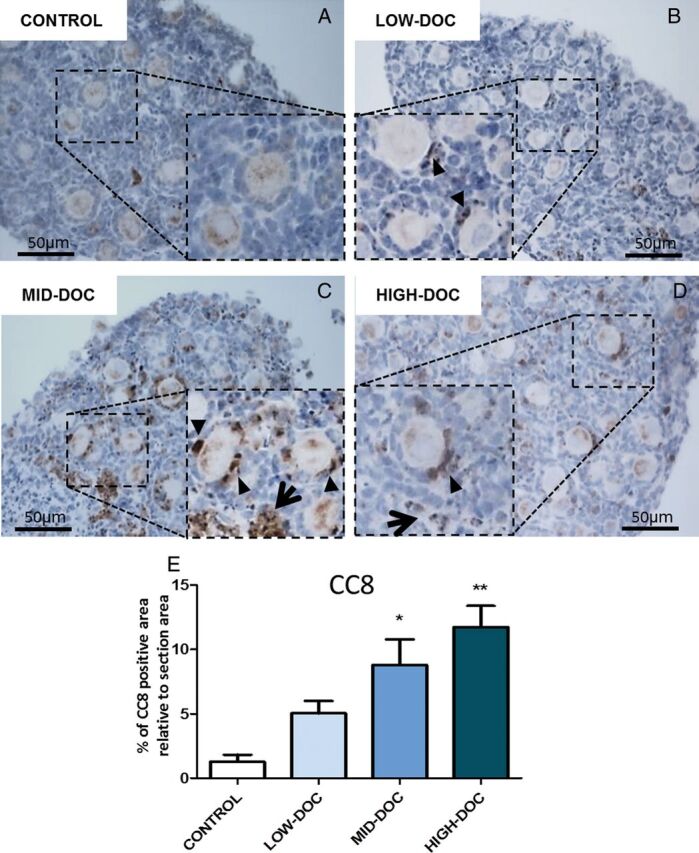
Docetaxel activates caspase 8. (A–D) Representative photomicrographs of mouse ovarian sections processed using immunohistochemistry to localize cleaved caspase 8 (CC8: brown), to illustrate the degree of apoptosis. (A) CONTROL ovary exhibiting little sign of CC8-positive apoptotic cells. (B–D) DOC-treated sections displaying marked apoptosis staining, with CC8 signal evident in many GCs (arrowhead) and stromal cells (arrow). Sections were counterstained with Haematoxylin (blue). Insets represent magnified images of respective framed areas. (E) Semi-automated analysis of immunohistochemistry. Exposure to DOC increased expression of CC8 relative to section area with the MID- and HIGH-DOC doses. Total of ovaries used in three independent experiments: CONTROL = 4, LOW-DOC = 4, MID-DOC = 6 and HIGH-DOC = 6. Kruskal–Wallis followed by Dunn post hoc tests were applied. Data are mean ± SEM. P < 0.05 (*), P < 0.01 (**) for DOC versus CONTROL.